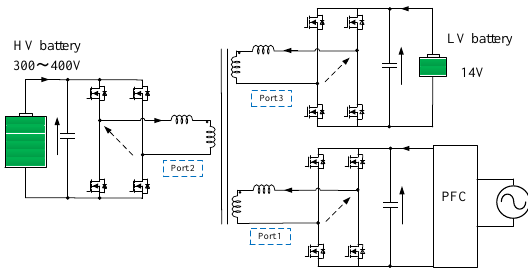
Figure 18. TAB converter for electric vehicles (EVs) application as an integrated on-board charger and DC-DC